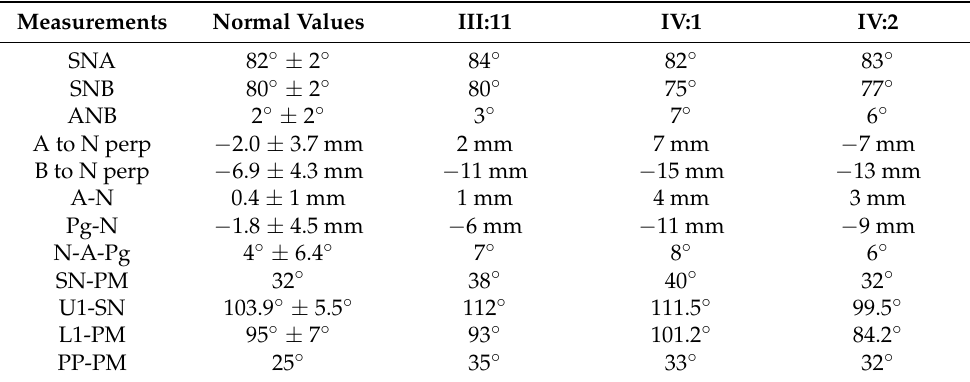
Figure 2. Cephalometric and panoramic radiographs of the affected individuals. ( a , b ) Cephalometric and panoramic radiographs of an aunt of the proband (III:11) at age 29 years 10 months. Impactions of the mandibular left third molar and maxillary left second and third molars were identified. Crown resorption (white arrow) of the impacted maxillary left second molar was found to have occurred. The anterior overbite appears to be within the normal range. ( c , d ) Cephalometric and panoramic radiographs of the proband (IV:1) at age 10 years 6 months. Hypocalcified enamel with reduced radiodensity is clearly observable in the developing second and third molars. The proband has an anterior open bite. ( e , f ) Cephalometric and panoramic radiographs of a younger brother of the proband (IV:2) at age 8 years 8 months. Multiple restorations were performed with a stainless-steel crown and resin composite. Anterior teeth tended toward mild to moderately deep overbite. Table 1. Cephalometric Measurements of the Affected